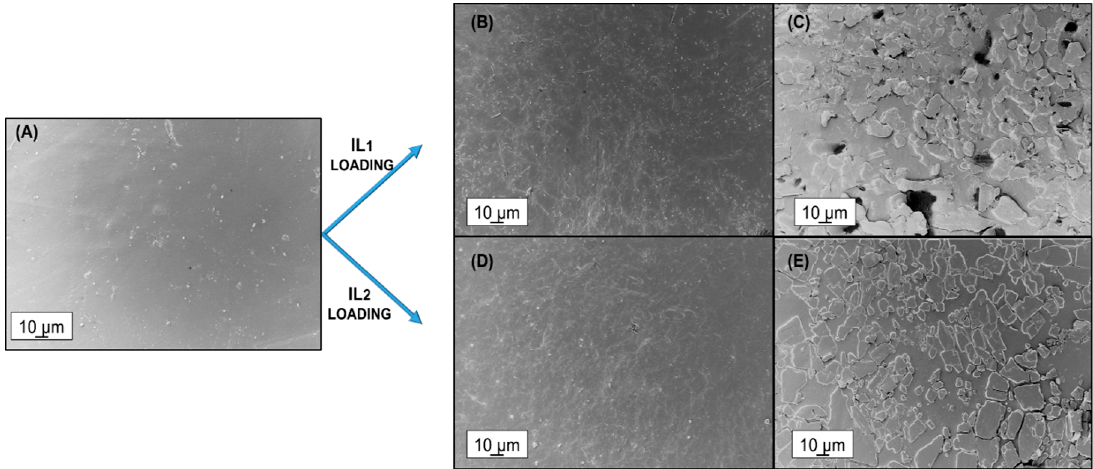
Figure 4. SEM images taken on the surface of Pebax ® Rnew and the blends with 5 wt.% ILs. ( A ) Neat Pebax ® Rnew; ( B ) Pebax ® Rnew / 1% IL1; ( C ) Pebax ® Rnew / 5% IL1; ( D ) Pebax ® Rnew / 1% IL2; and ( E ) Pebax ® Rnew / 5%IL2.